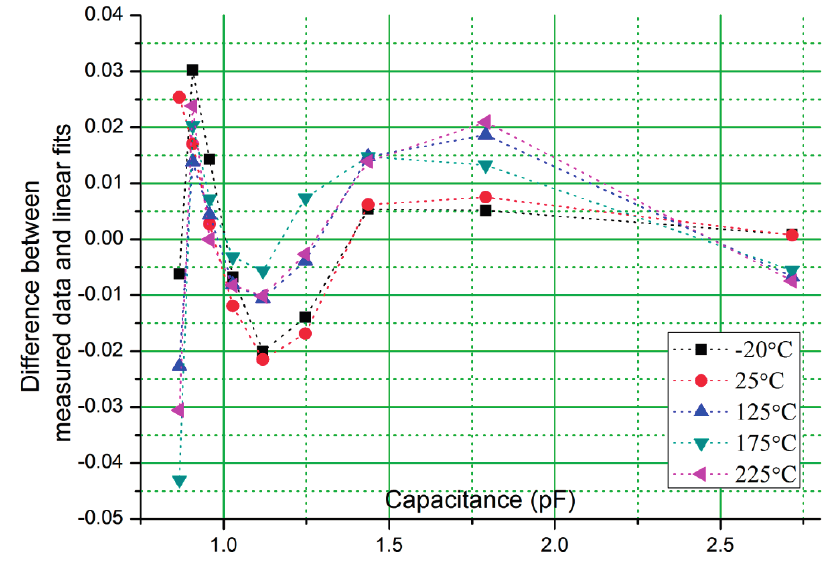
Figure 6. Difference between measured results and linear